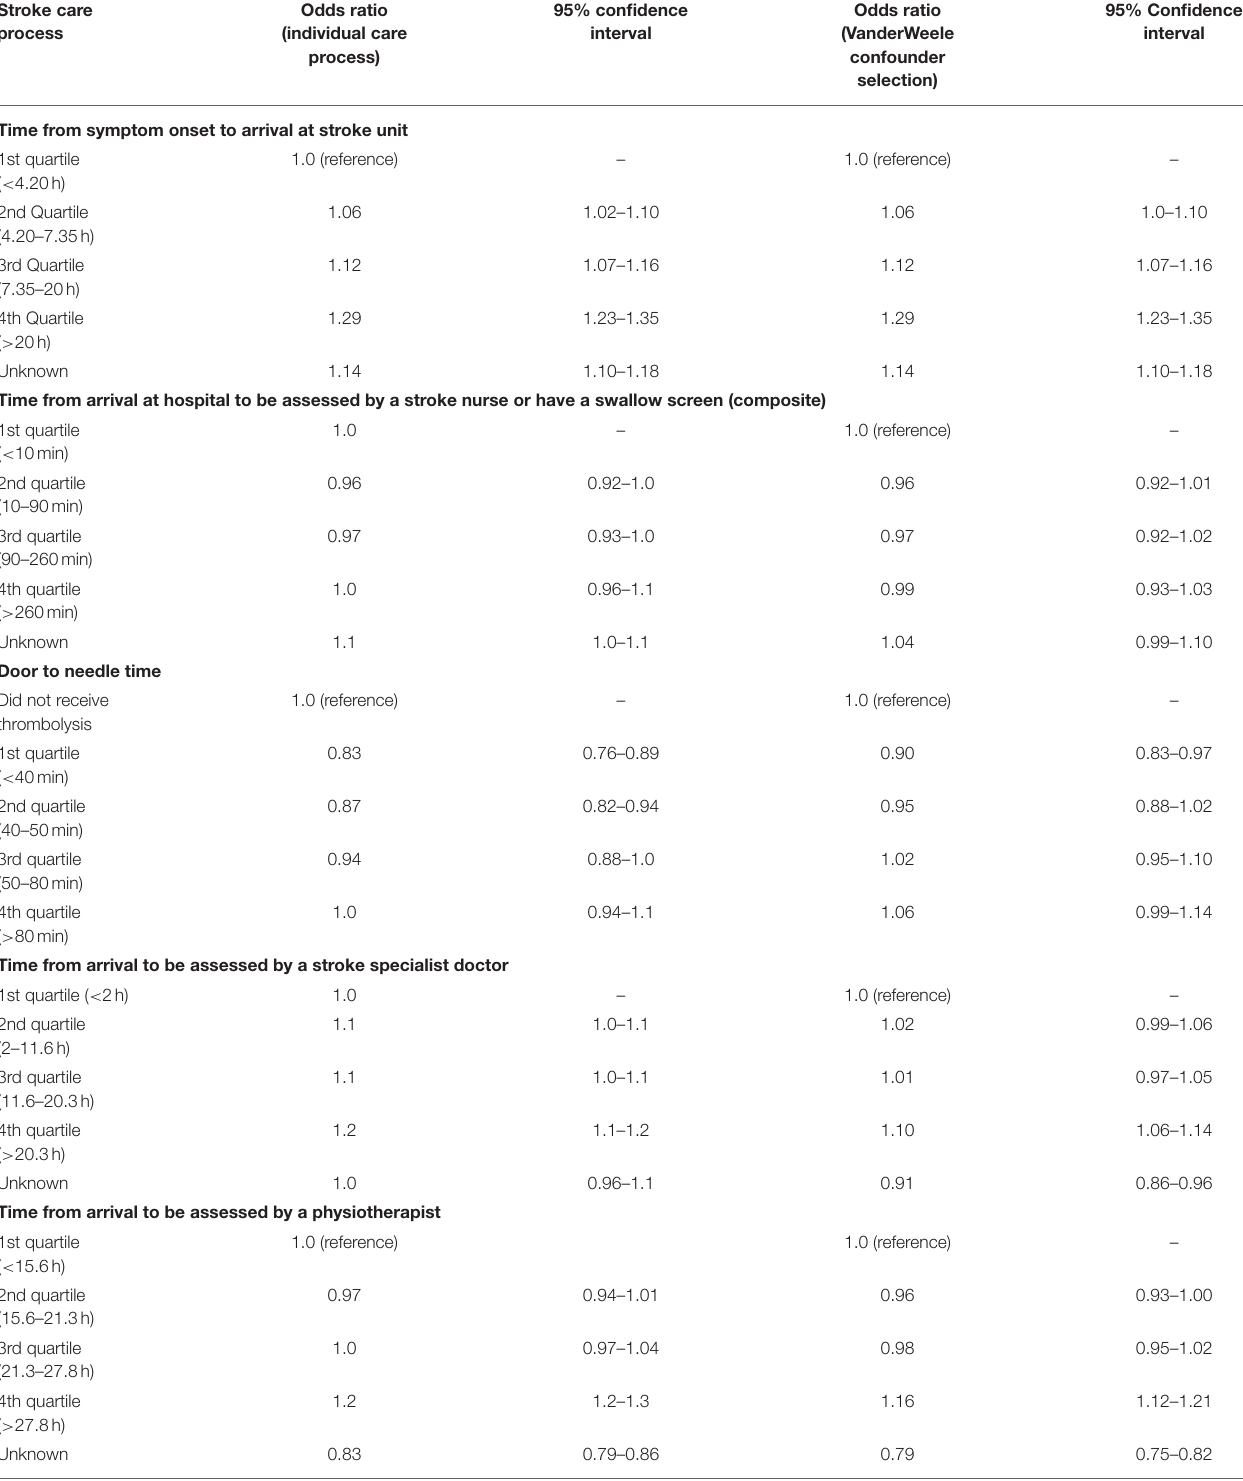
TABLE 1 | Multivariable multilevel logistic regression odds ratios for stroke care processes describing their association with SAP. Stroke care